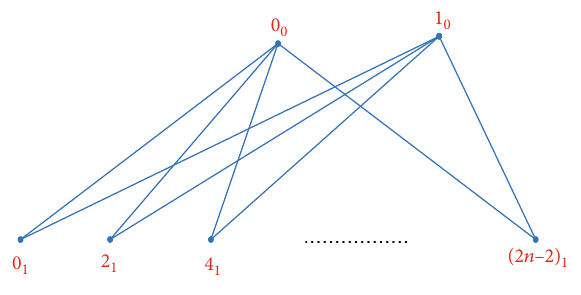
Figure 6: An orthogonal labeling for K